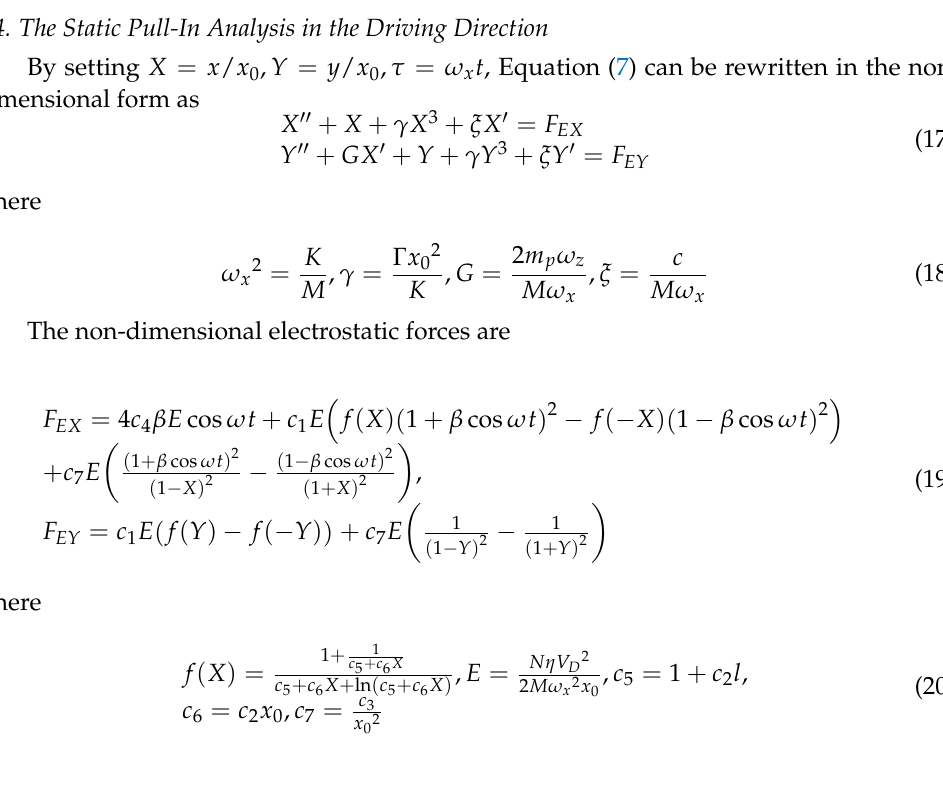
Figure 7. The inclination effect on the linear and nonlinear stiffness: the FEA results and fitting results. ( a ) The inclination effect on the linear stiffness, ( b ) The inclination effect on the nonlinear